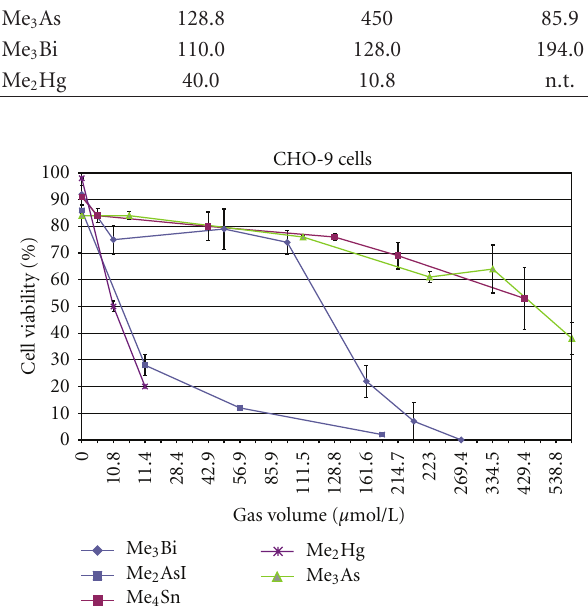
Figure 2: Comparison of cytotoxicity of 5 di ff erent metal(loid) compounds (Me 3 Bi, Me 4 Sn, Me 3 As, Me 2 AsI, and Me 2 Hg) in CHO- 9 cells. The experiments were repeated twice.